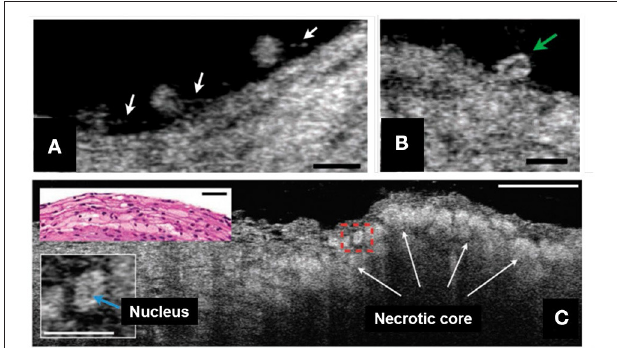
FIGURE 3 | µ OCT for inflammatory cell morphology in human cadaver coronaries ex vivo. (A) Multiple leukocytes tethered to the endothelial surface by linear structures, suggestive of pseudopodia (white arrows). (B) A cell with an indented, bean-shaped nucleus (green arrow) suggestive of a monocyte. (C) Necrotic core fibroatheroma with highly scattering lipid-laden macrophages or foam cells (white arrows) infiltrating the fibrous-cap that were similarly seen in the corresponding histology (top left inset). An intracellular region of low signal, a suggestive of the nucleus, was shown within the cytoplasm of a foam cell (bottom left inset, denoted by blue arrow). Scale bars, 30 µ m. Figure and capture reprinted with permission from Liu et al. (28).